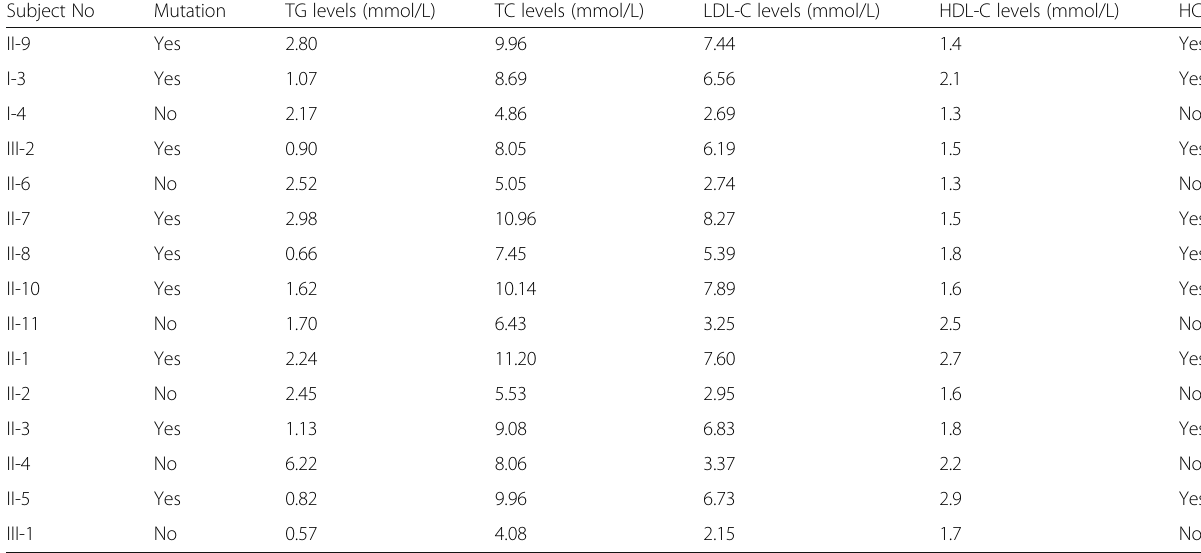
Table 3 Blood lipid profiling and mutation results of all